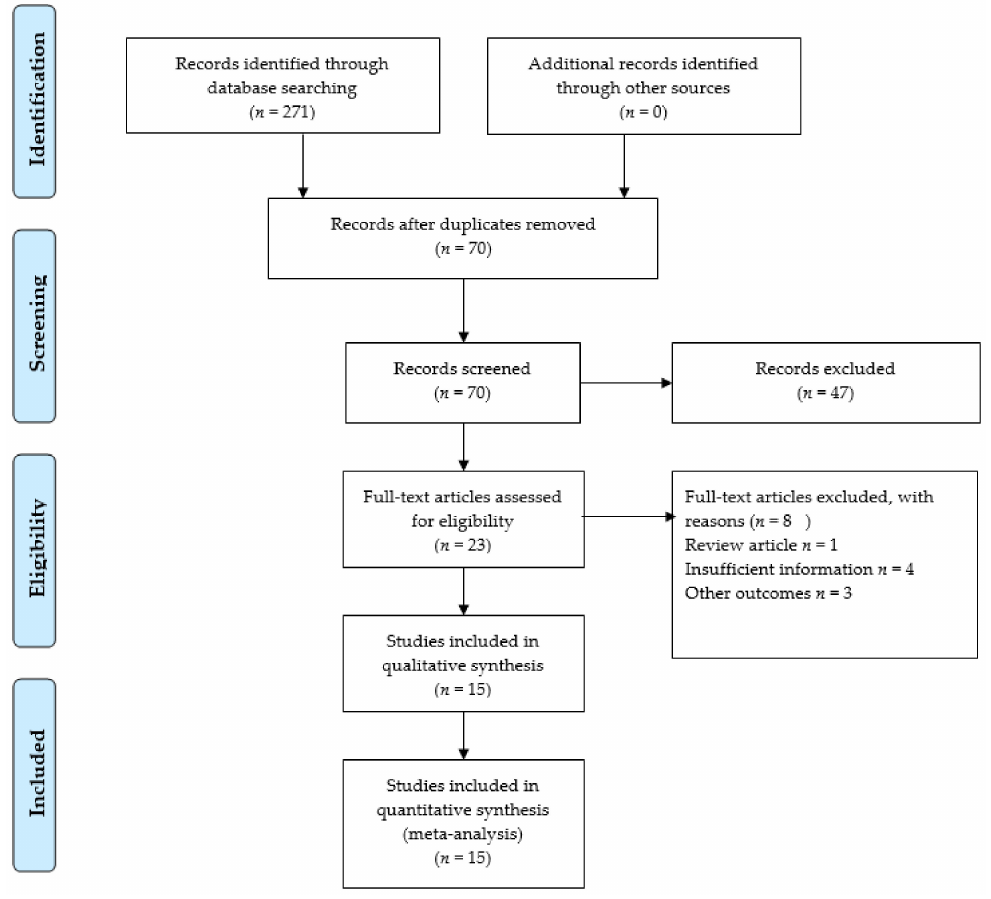
Figure 2. Search